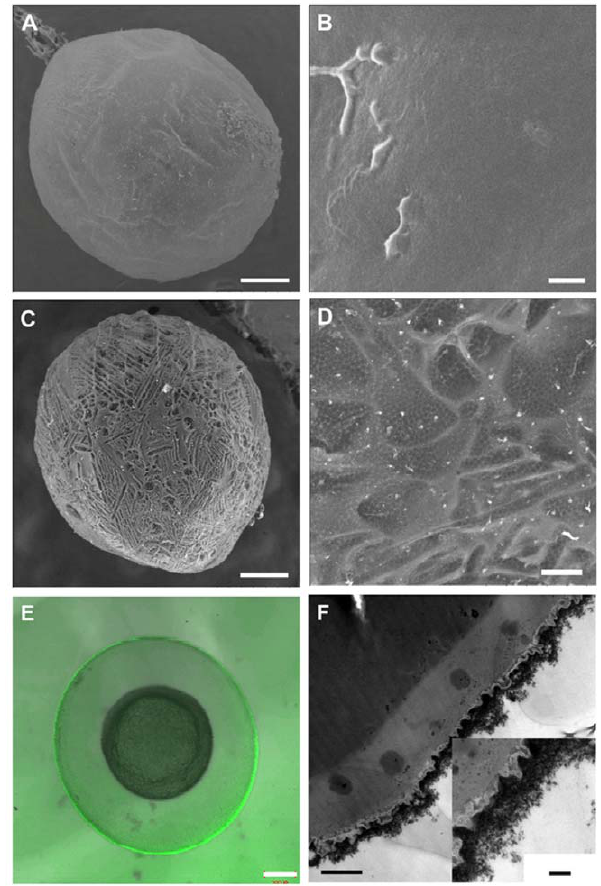
Figure 1. Images of the bare embryo and the coated embryo. A. SEM images of the bare embryo and ( B ) surface of the bare embryo. C. SEM images of the coated embryo with mineralized shell and ( D ) porous surface of the shell. E. Laser scanning microscopy image of the coated embryo with green-emission fluorescent shell. F. Transmission electron microscopy (TEM) the cross section image of the shell- engineered embryo. Scale bars, 200 m m ( A, C, E ), 2 m m ( B, D ), 1 m m ( F ), 200 nm ( F , the insert